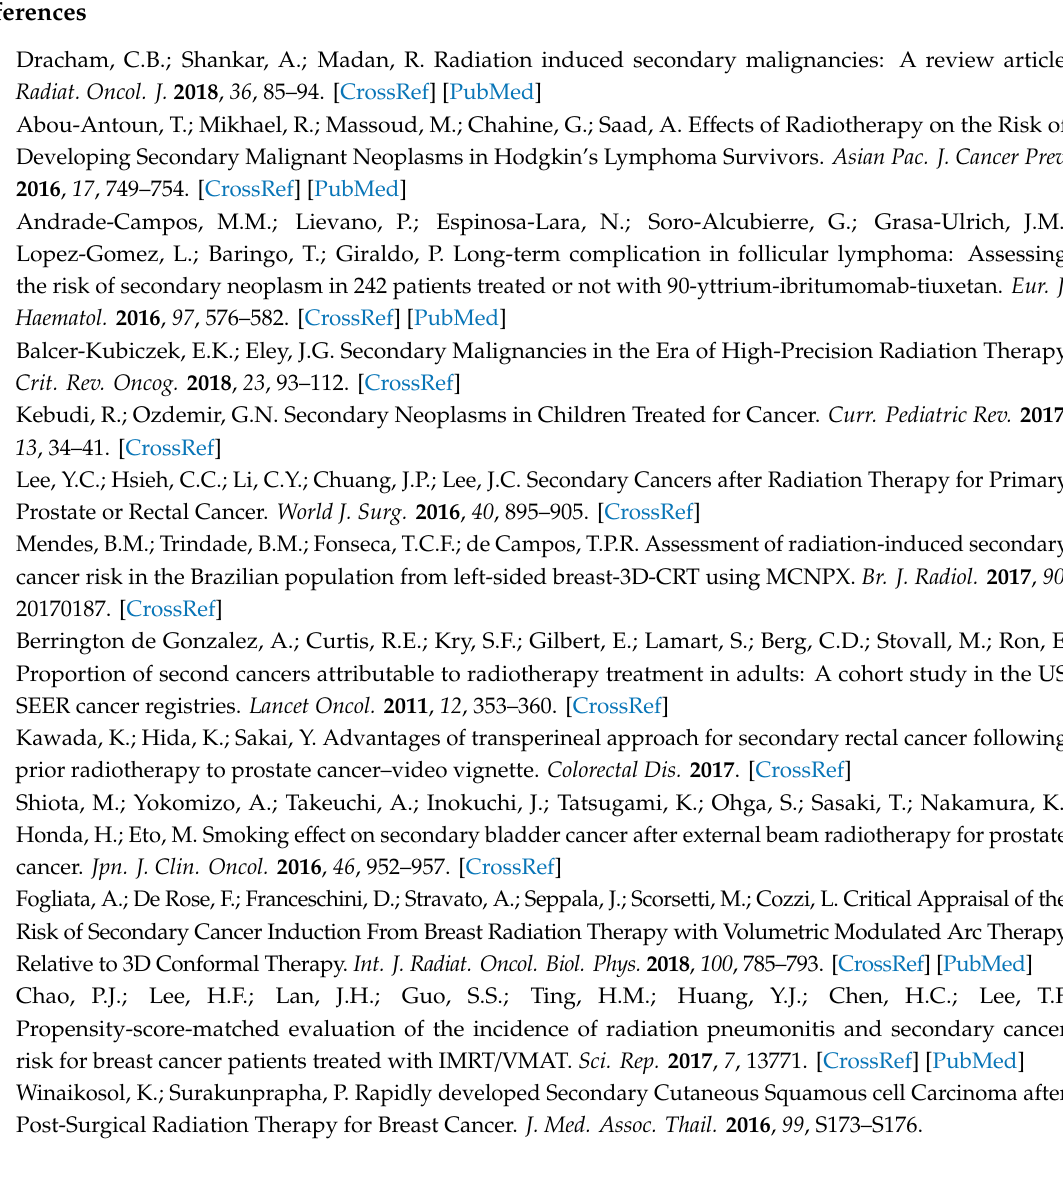
Figure S1: The cumulative incidences of death and secondary primary malignancy in colon adenocarcinoma divided by tumor sites before and after propensity score matching. Table S1: Codes for patient selection based on the International Classification of Diseases for Oncology, third edition (ICD-O-3), Table S2: Stratified analyses according to